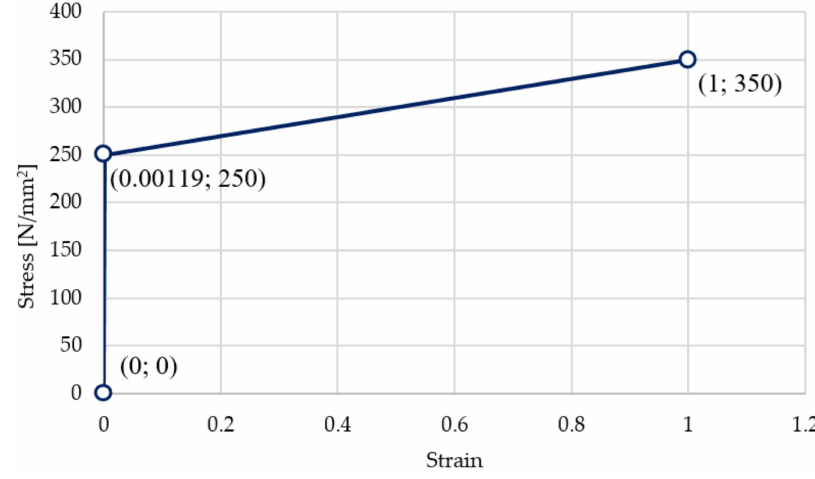
Figure 9. Tensile diagram in sigma–epsilon coordinates for the steel